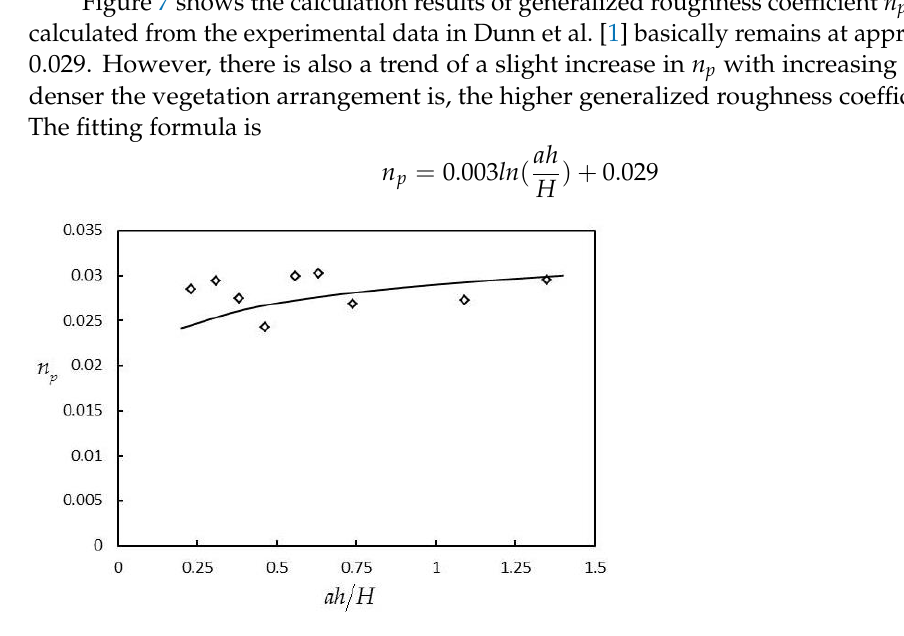
Figure 7. Generalized roughness coefficient n p varies with the comprehensive parameter ah/H .